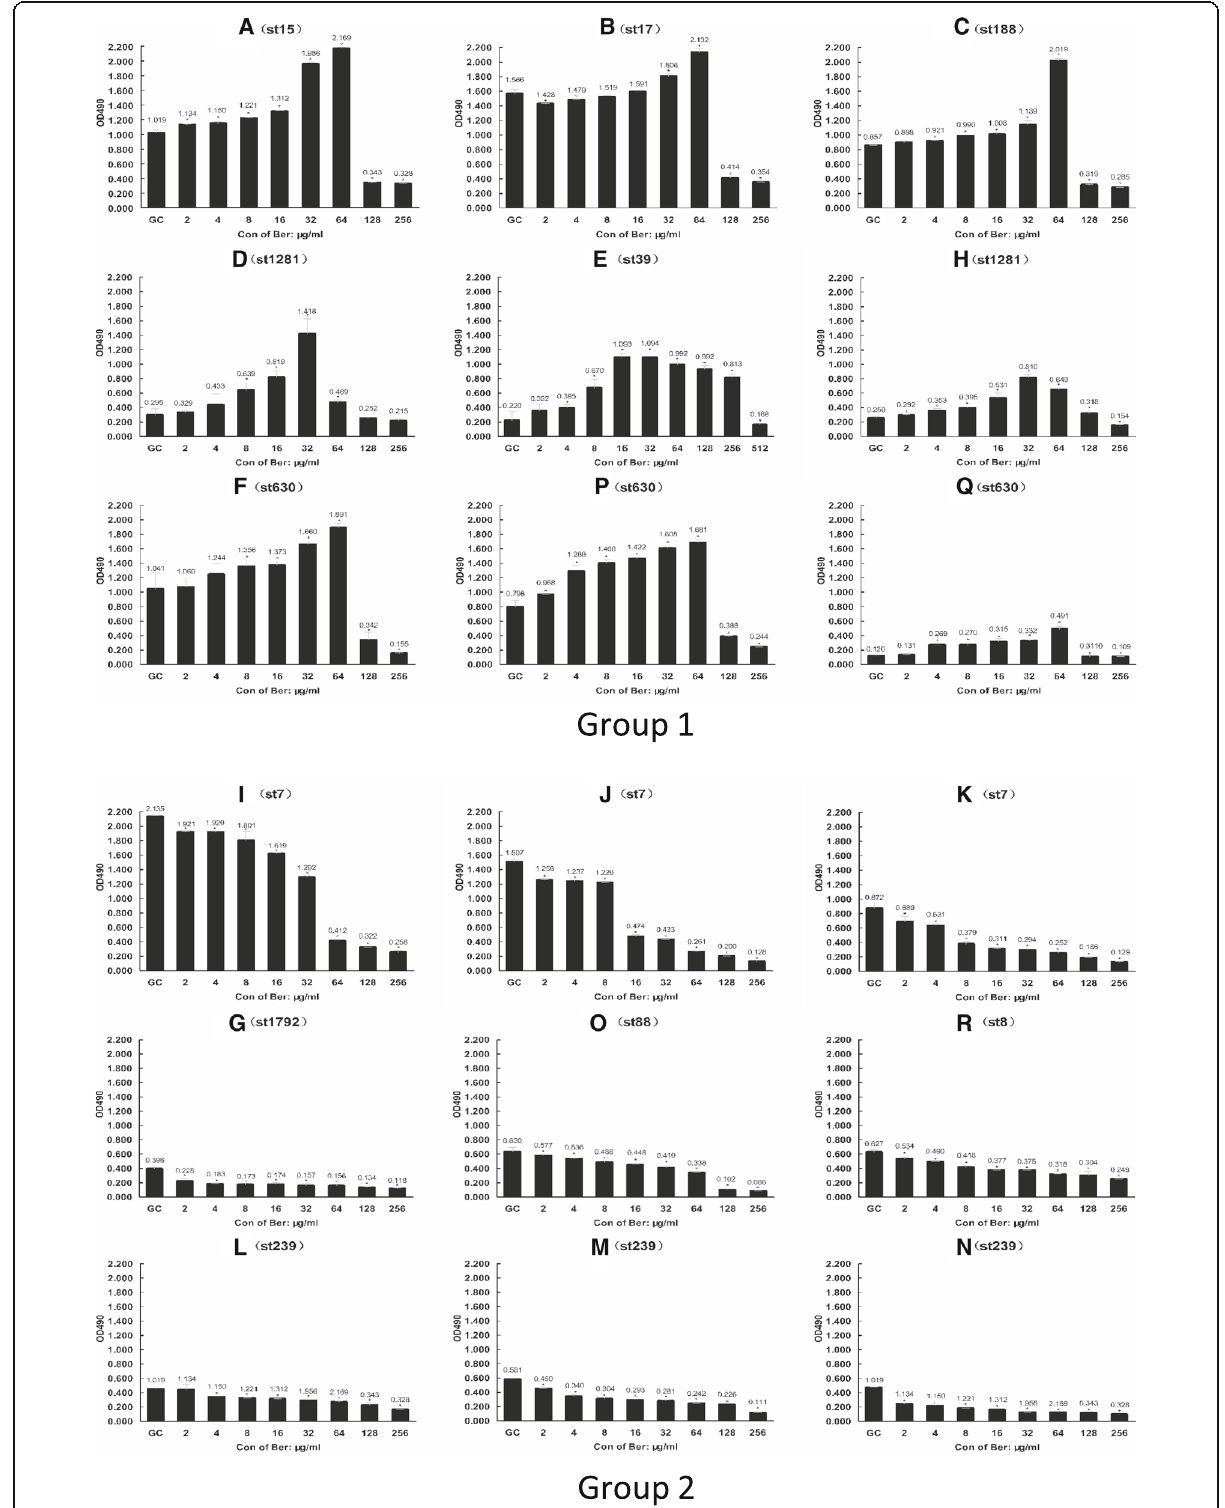
Fig. 3 Inhibitory effects of berberine on clinical S.aureus biofilm formation. S. aureus strains were inoculated into TSB and cultured with different concentrations of berberine. Wells containing 1% DMSO and bacteria was the bacterial growth control (GC). Data are presented as mean±standard deviation. *Significance was determined at P <0.05 with comparison to the control